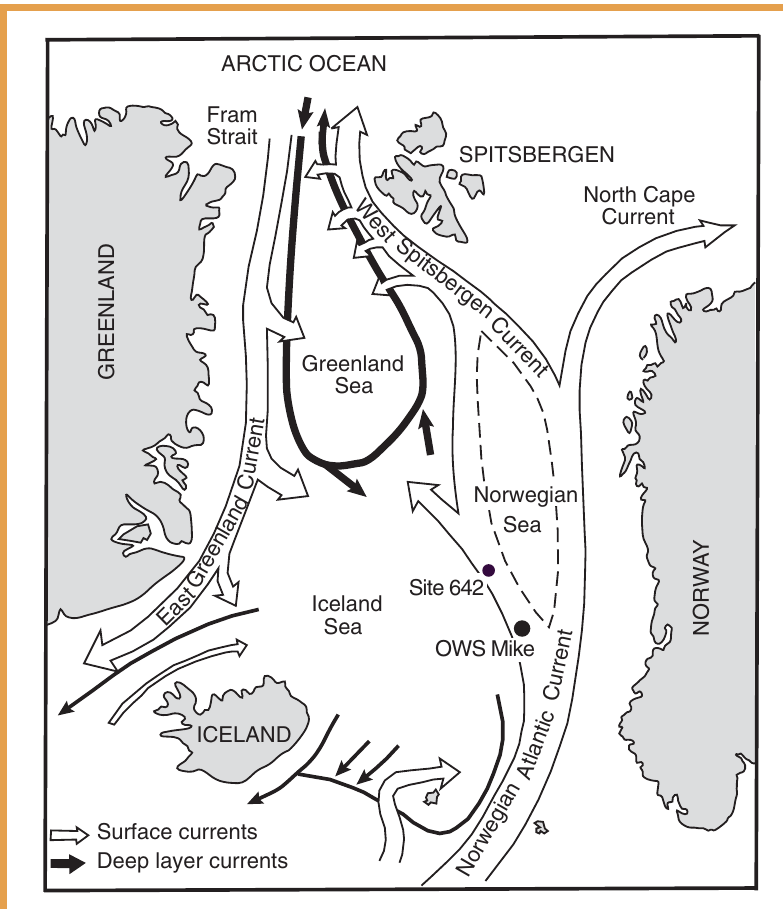
Figure 1. Location map of the Norwegian Sea and Vøring Plateau showing ODP Site 642 and Ocean Weather Ship Station “Mike” (modi fi ed from Gammelsrød et al.,